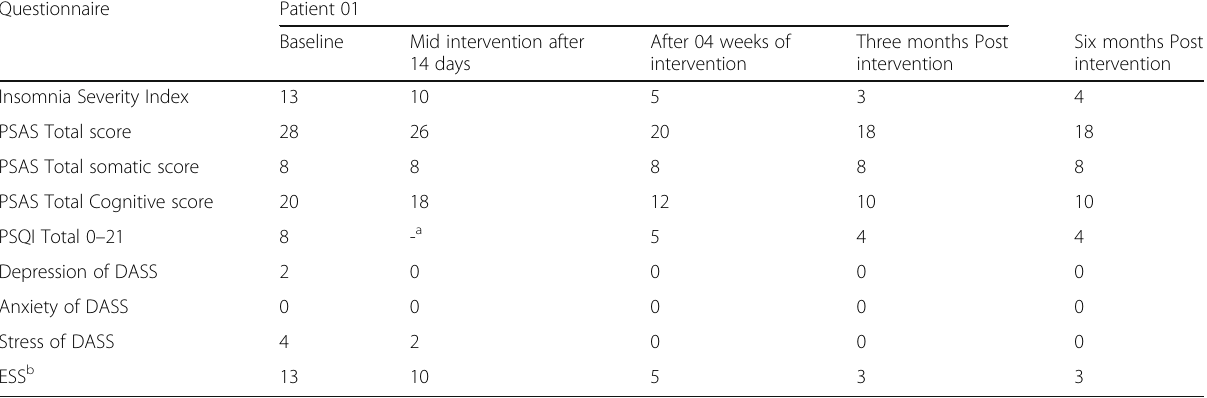
Table 1 Questionnaires of patient 01 during the intervention and at follow ups